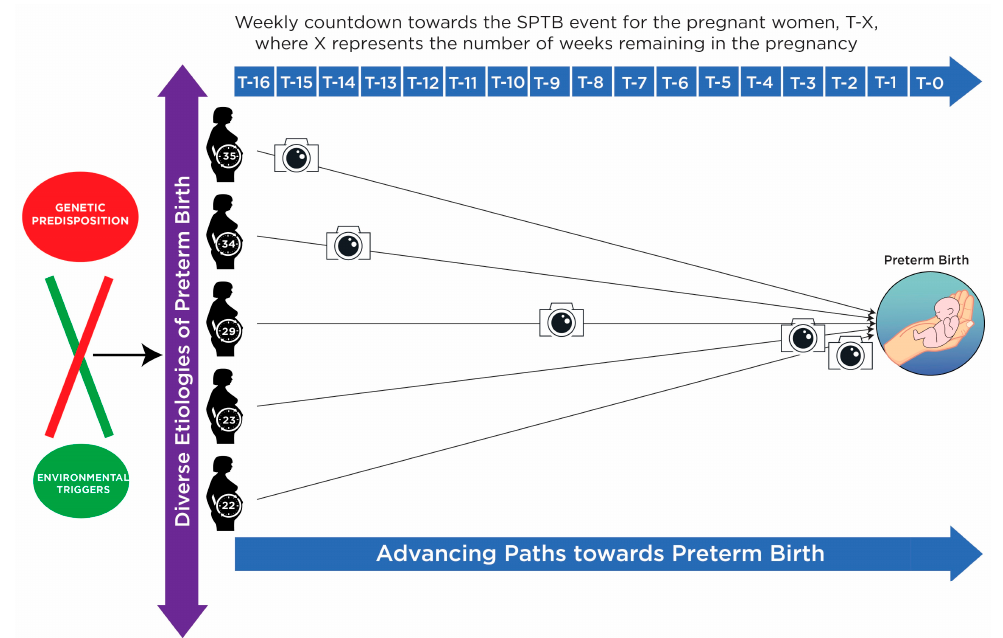
Figure 1. Schema depicting the molecular state of this spontaneous preterm birth (SPTB) dataset at metabolomics sampling time using a representative set of 5 patients. Diverse etiologies leading to SPTB ultimately converge in the final premature birth event. All women in the dataset were sampled at 20 weeks’ gestation, therefore at the same time relative to the start of their pregnancies. However, relative to the preterm birth event, the women were sampled at a variety of time points. For example, women who gave birth at 22 weeks were sampled at T-2 weeks and women who gave birth at 35 weeks were sampled at T-15 weeks. Snapshots (depicted by camera icons) of metabolomic activity taken at different stages preceding the SPTB even will be more divergent the further they are from the event.